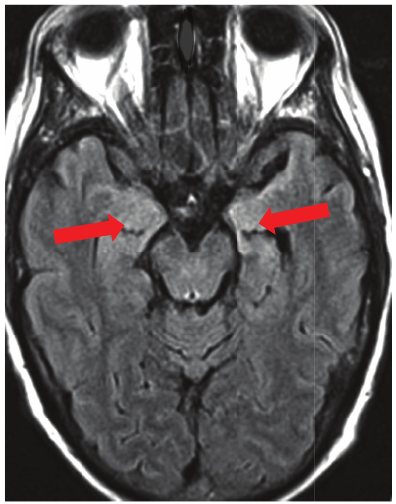
Figure 1: MRI FLAIR of a patient with limbic encephalitis and posi- tiveNMDARantibodiesintheCSF.Increasedsignalintensityisseen in the bilateral medial temporal lobes and